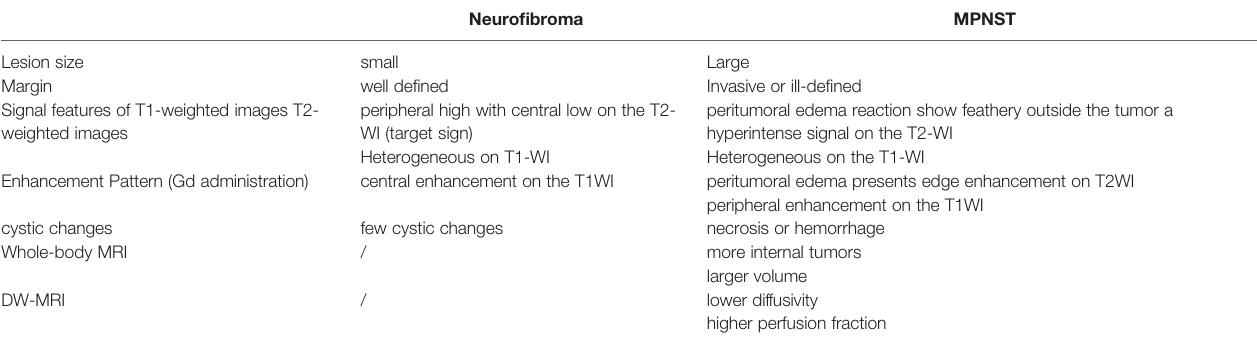
TABLE 1 | Features of Neuro fi broma and MPNST on MRI.